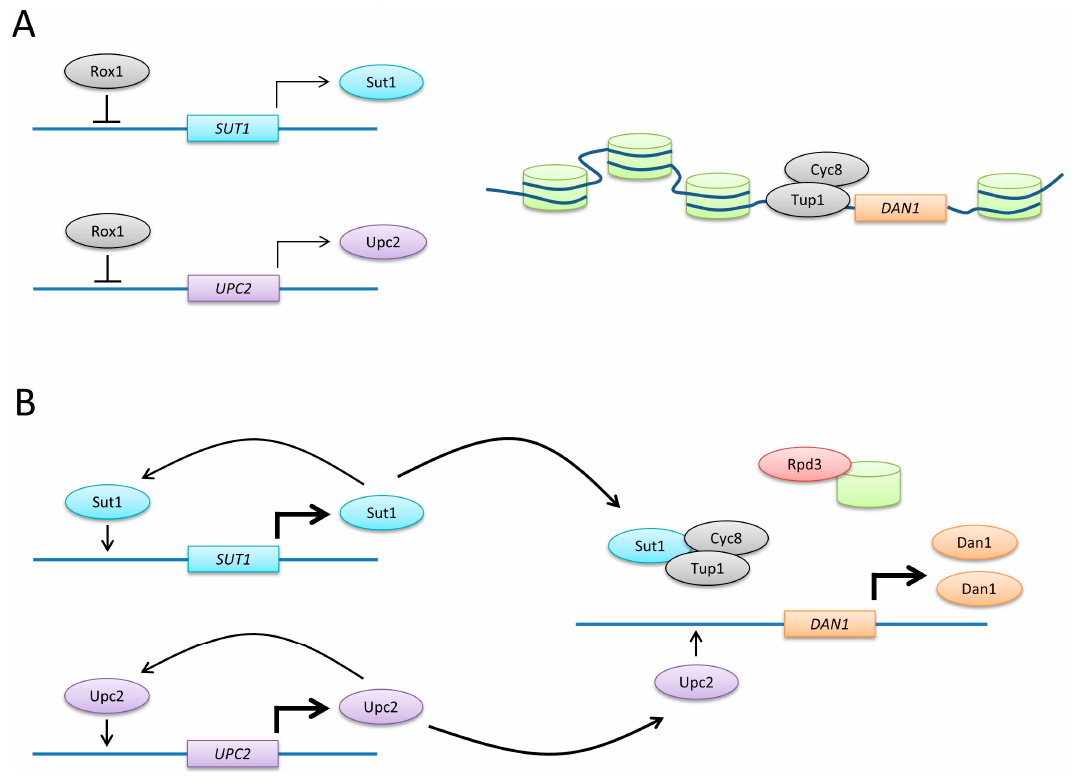
Figure 5. Transcriptional regulation of DAN1 . ( A ) SUT1 and UPC2 are partially repressed by Rox1 in the presence of oxygen. The anaerobic gene DAN1 is not expressed due to chromatin-mediated